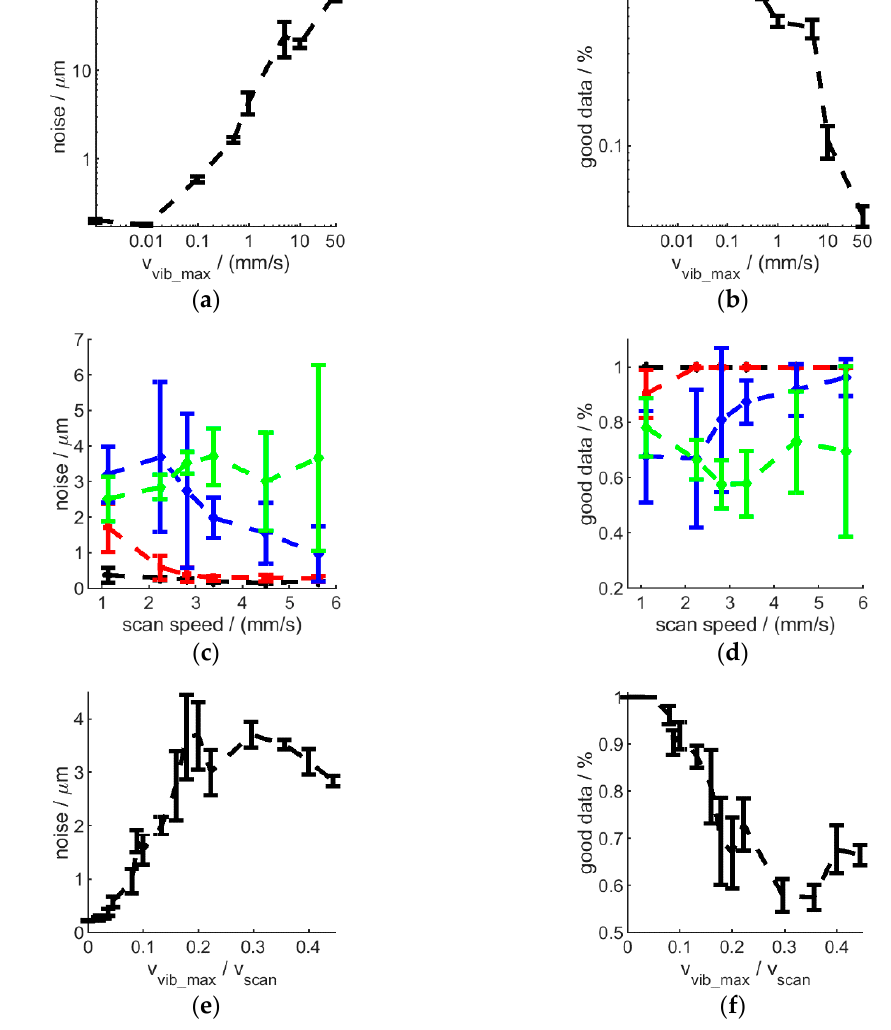
Figure 12. The effect of sample vibration peak velocity ( a , b ), measurement (scan) speed ( c , d ) and vibration-measurement speed ratio ( e , f ) on the instrument performance in terms of noise ( a , c , e ) and data quality ( b , d , f ), standard deviation is shown by the error bars. Highest instrument Z resolution and R5 lens used. Panel ( a , b , d , f ) vibration frequency range in {0, 1, 10, 100, 500} Hz and amplitudes in {0, 1, 10, 100, 500} µ m; panel c and d: 0 Hz, 0 µ m (black); 10 Hz, 10 µ m (red); 45 Hz, 10 µ m (blue); 100 Hz, 10 µ m